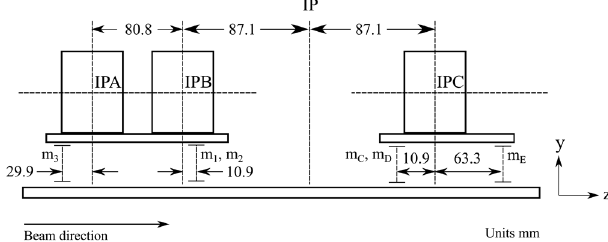
FIG. 5. Schematic of the IP BPM configuration, showing the IPAB mover block, with submovers m 1 , m 2 , and m 3 , on which IPA and IPB are mounted, and the IPC mover block with submovers m , m and m . The nominal IP location, as used C D E for beam-size measurements, is